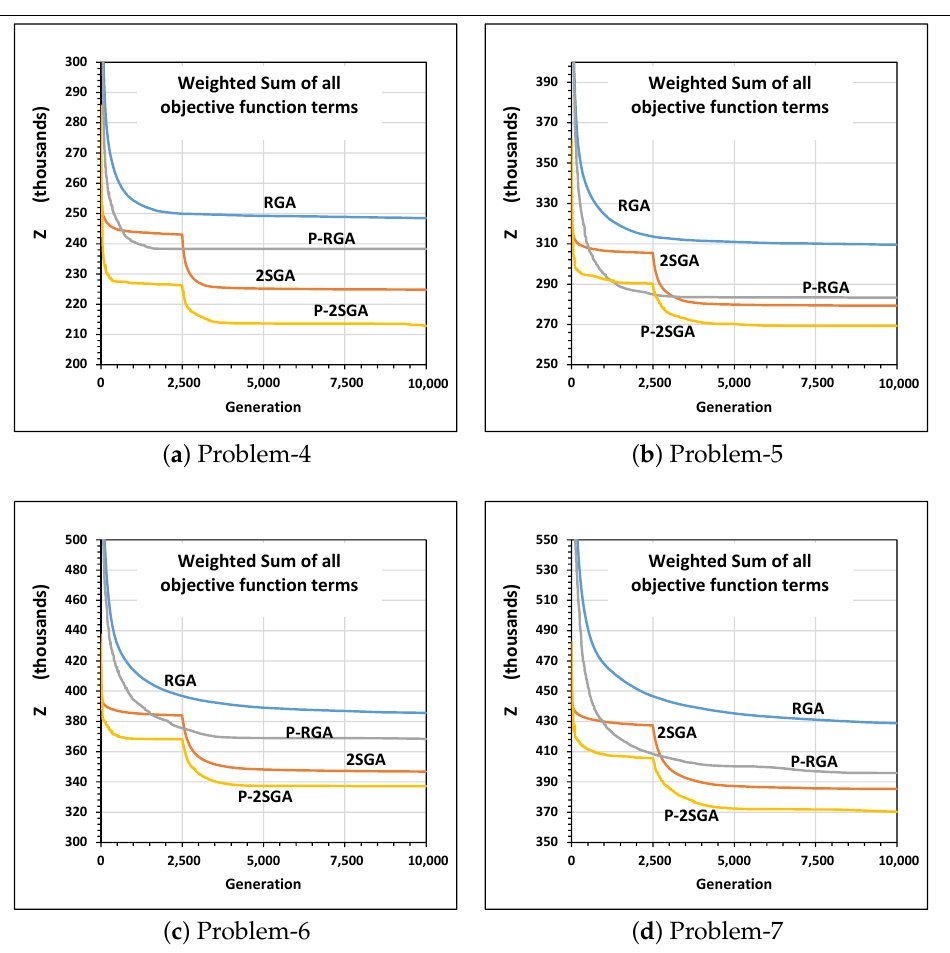
Figure 15. Improvements of convergence behaviors of RGA and 2SGA using the parallelization